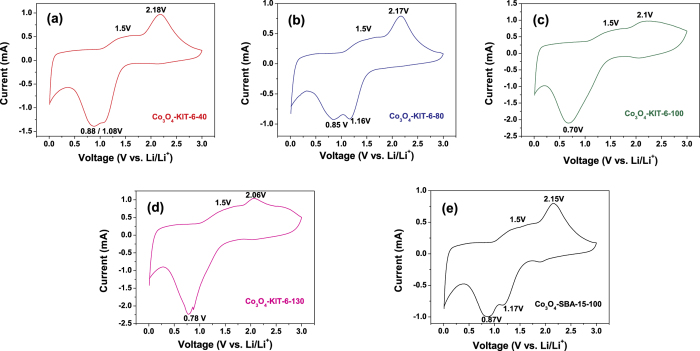
CV curves of the ordered mesoporous Co3O4 electrodes at a scan rate of 0.5 mV s−1.